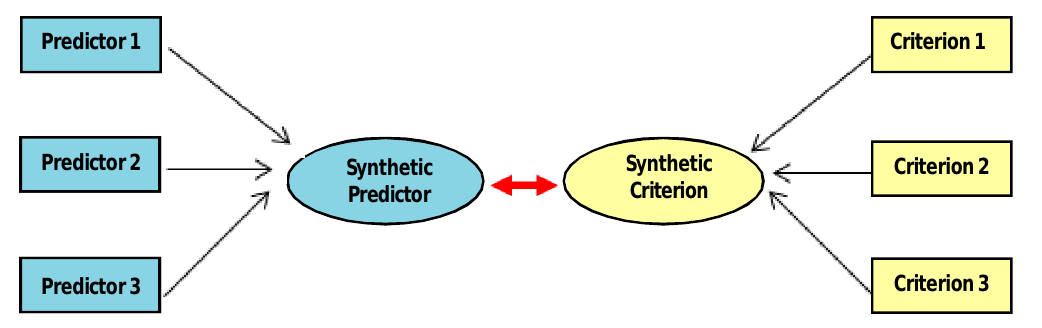
Figure 1. Relationship between a set of predictor variables and a set of criterion